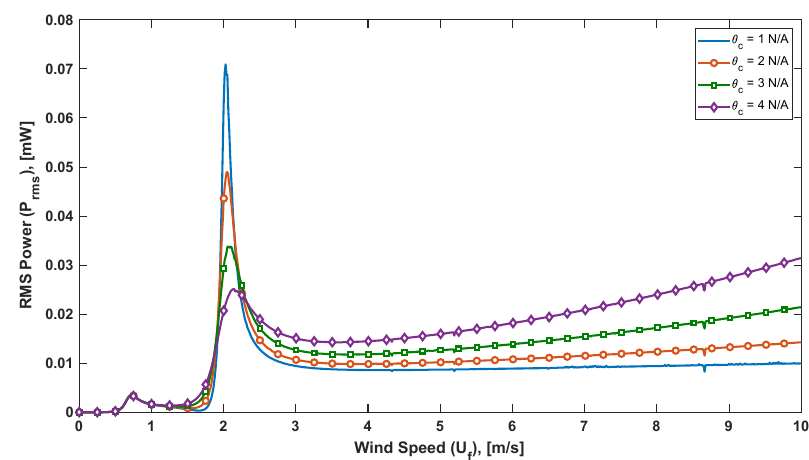
Figure 14. The effect coupling coefficient ( 𝜃 (cid:3030) ) on the harvester output power.